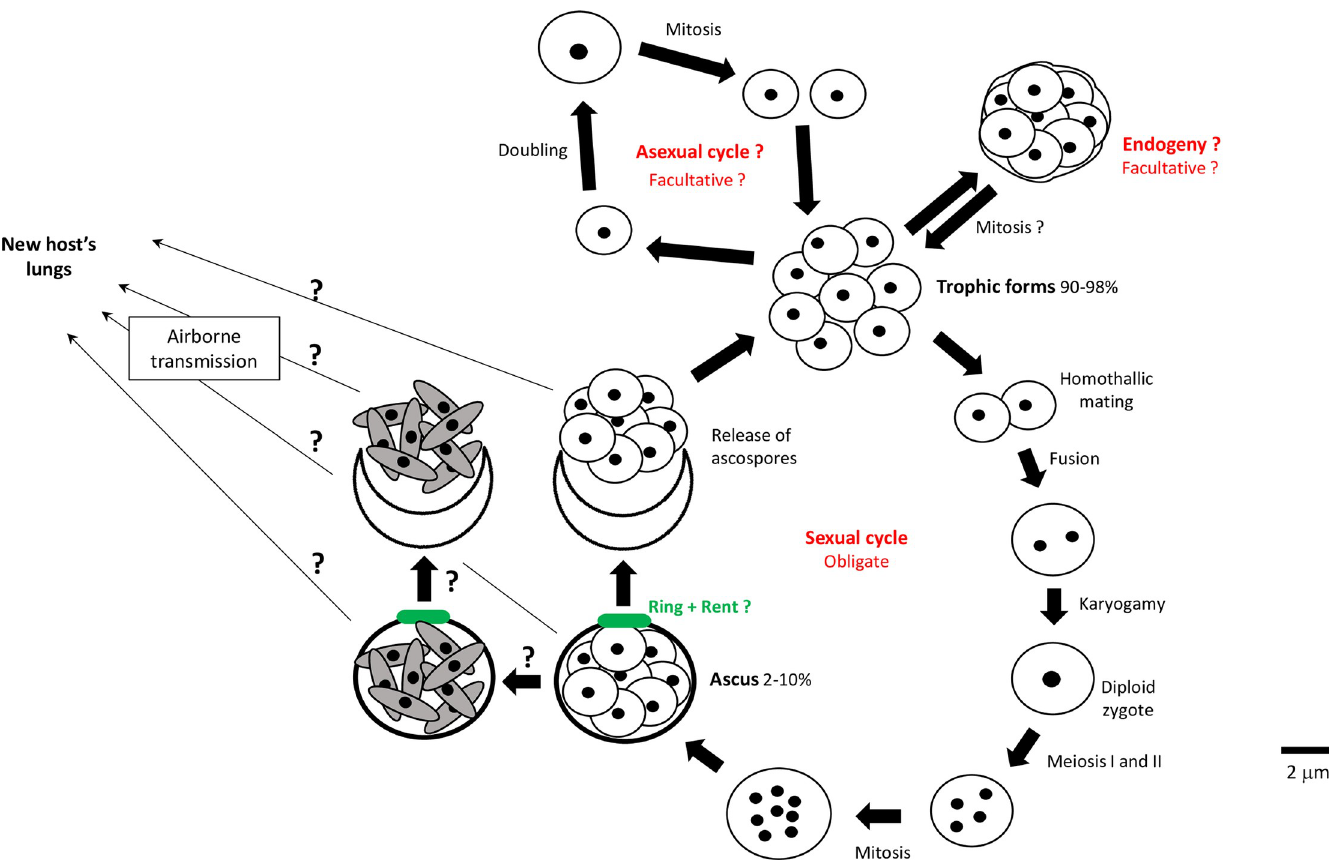
Fig 1. Hypothetical life cycle of Pneumocystis . Black dots represent nuclei. The question marks indicate events not or poorly supported by the data [9–11]. Elongated ascospores that present a condensed cytoplasm are shown as gray spindle-shaped